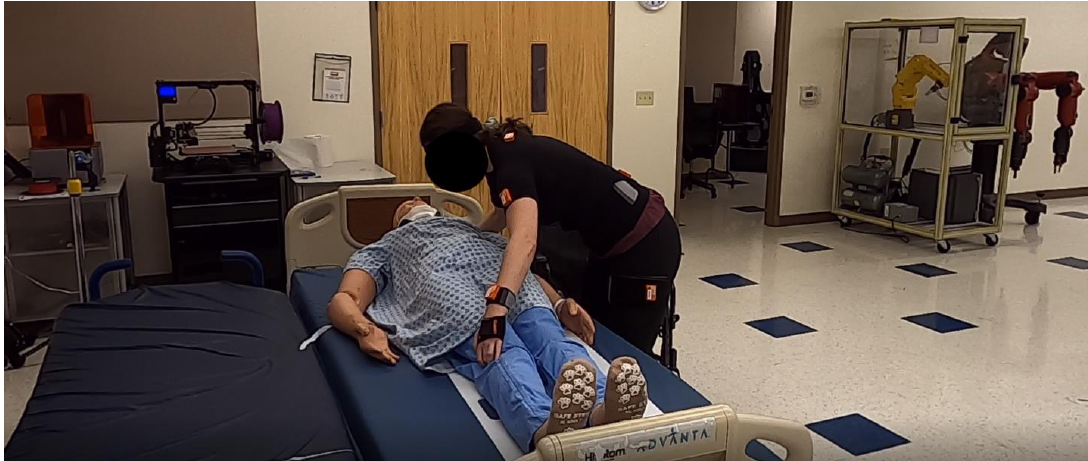
Figure 1. Task#1: Moving the patient manikin from a lying position to a sitting position in bed. Task#2: Each participant was required to transfer the patient manikin from the edge of a hospital bed to a wheelchair (Everest & Jennings Product), as shown in Figure 2. This task involved the following steps: (1) leaning the body forward, (2) lifting the manikin up to a standing position by applying an upward force on the underarms of the manikin, (3) firmly holding the manikin straight, (4) moving the manikin in front of the wheelchair, and (5) gently placing the manikin onto the chair.